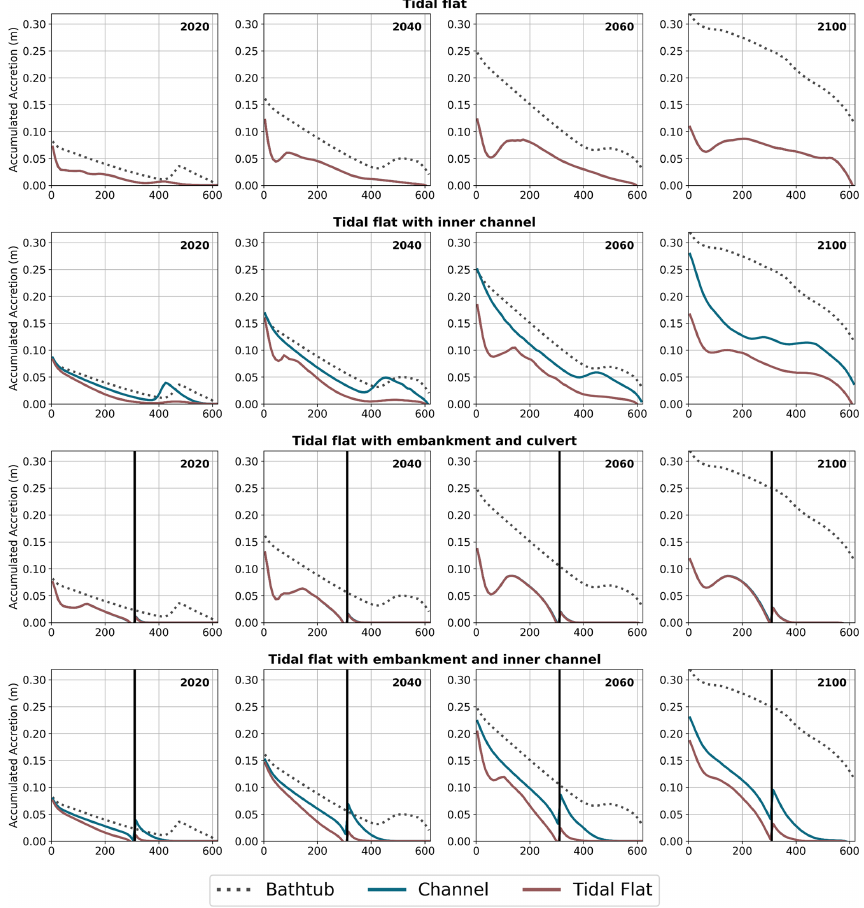
Figure 3. Longitudinal profiles of accumulated accretion ( (cid:49)E , m ) for a sediment supply of 37gm − 3 . The vertical black line represents the embankment with culvert. The “channel” profile represents the elevation gain near the central channel, while the “tidal flat” profile is situated in the middle of the tidal flat. Note: simulation starts in the year